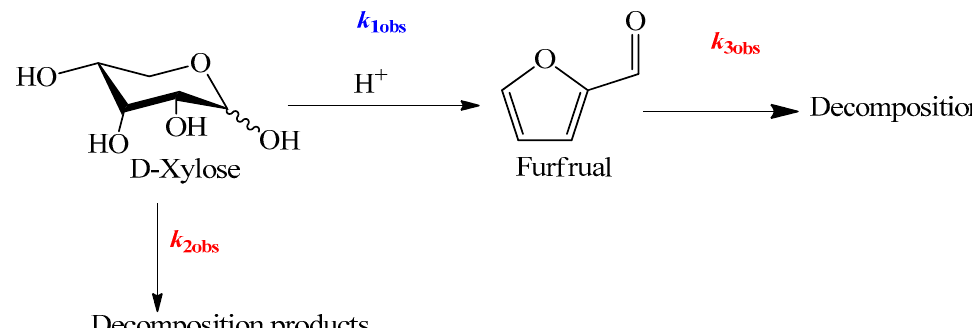
Scheme 1. Acid-catalyzed conversion of xylose to